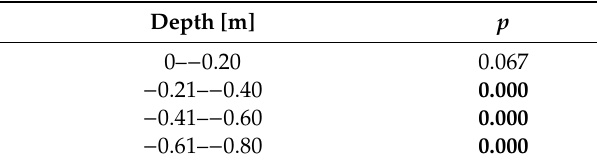
Table 16. Kruskal–Wallis test for simplified areas (Undisturbed, CUT EX, SUC, REF). Significantly different areas (p < 0.05) are indicated bold.